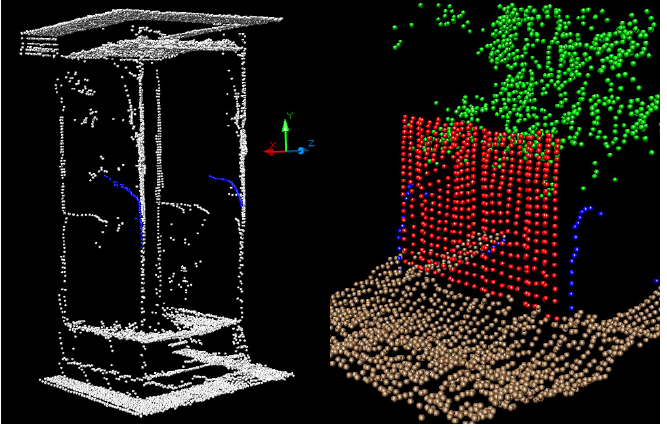
Figure 6. The blue-coloured points are manifestations of the edge effect (mixed pixels) when the laser beam partially fell on the edge of some